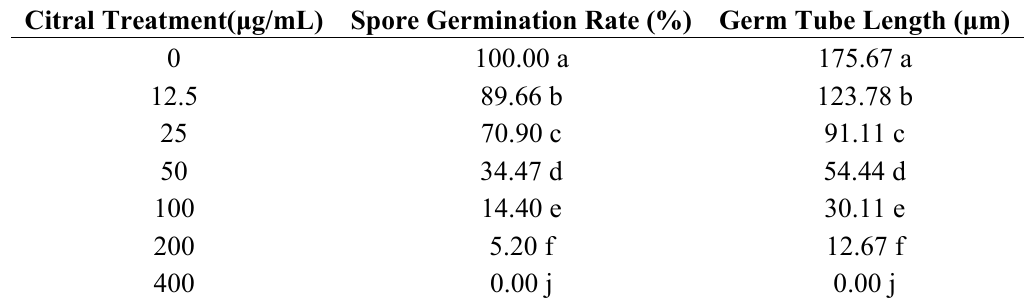
Values represent means of measurements for six independent plates per treatment. In each column, the values followed by the same letter do not differ significantly for p <